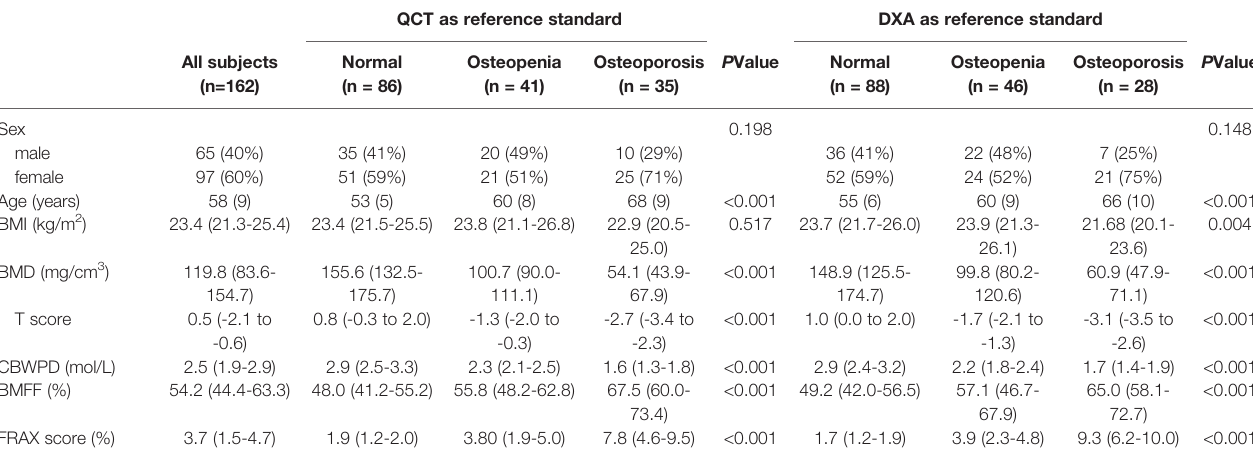
TABLE 1 | Characteristics of patients in three cohorts of normal subjects, patients with osteopenia, and patients with